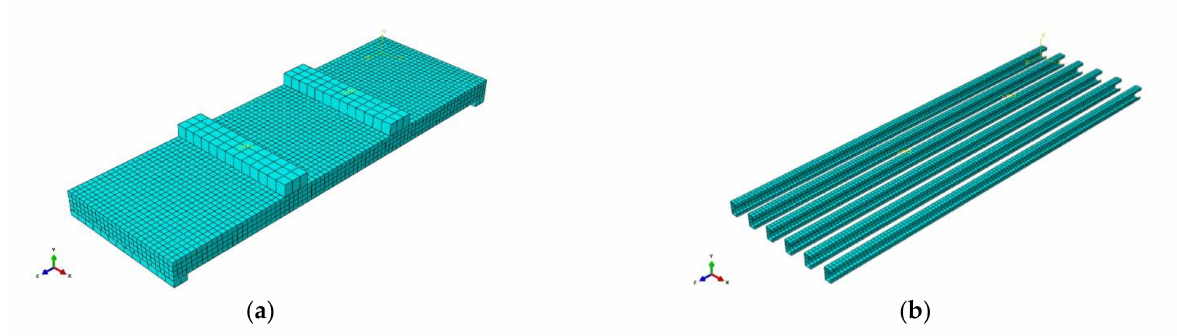
Figure 11. Mesh of the model. ( a ) Mesh of the foam concrete slab; ( b ) Mesh of cold-formed thin-walled C steel